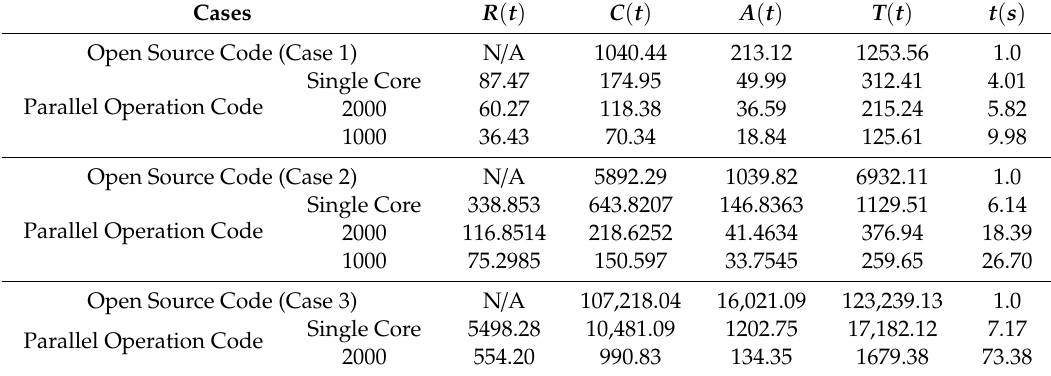
Table 4. Run time in di ff erent configurations for 2-D Dry-Bed Dam Break with particle splitting.